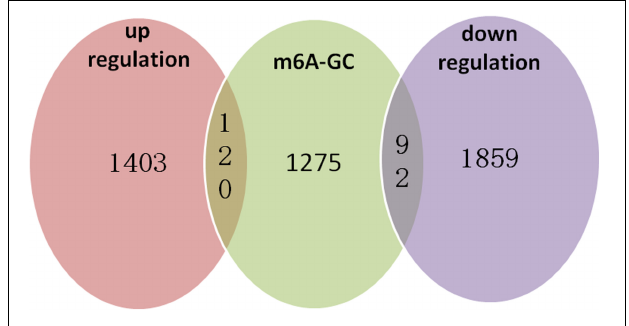
FIGURE 7 | m6A methylation genes with the related mRNA differentially expressed genes in GC. We performed a combination analysis of 1,487 m6A methylation genes with related mRNA differently expression genes in GC and found 120 up-regulation genes and 92 down-regulation genes were related m6A methylation.